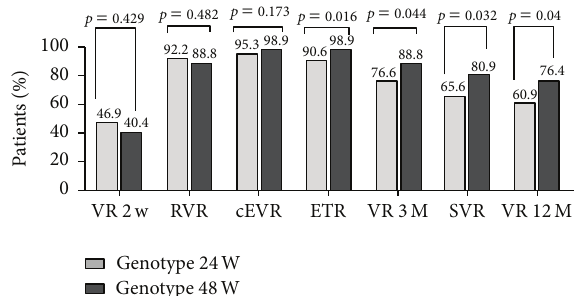
Figure 2: Comparison of the virological response rate between patients with HCV-6a infection treated for 48 weeks and 24 weeks. VR 2 W, virological response at week 2 of therapy; VR 3 M, virological response at month 3 of end-of-treatment; VR 12M, virological response at month 12 of end-of-treatment. RVR, rapid virologic response; cEVR, complete early virologic response; ETR, end-of-treatment response; SVR, sustained virologic